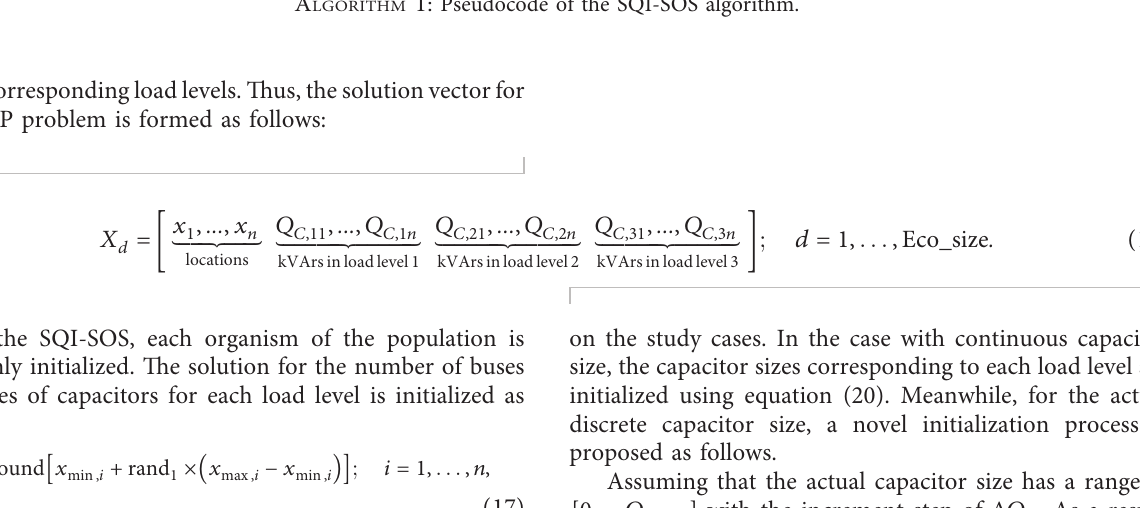
A LGORITHM 1: Pseudocode of the SQI-SOS